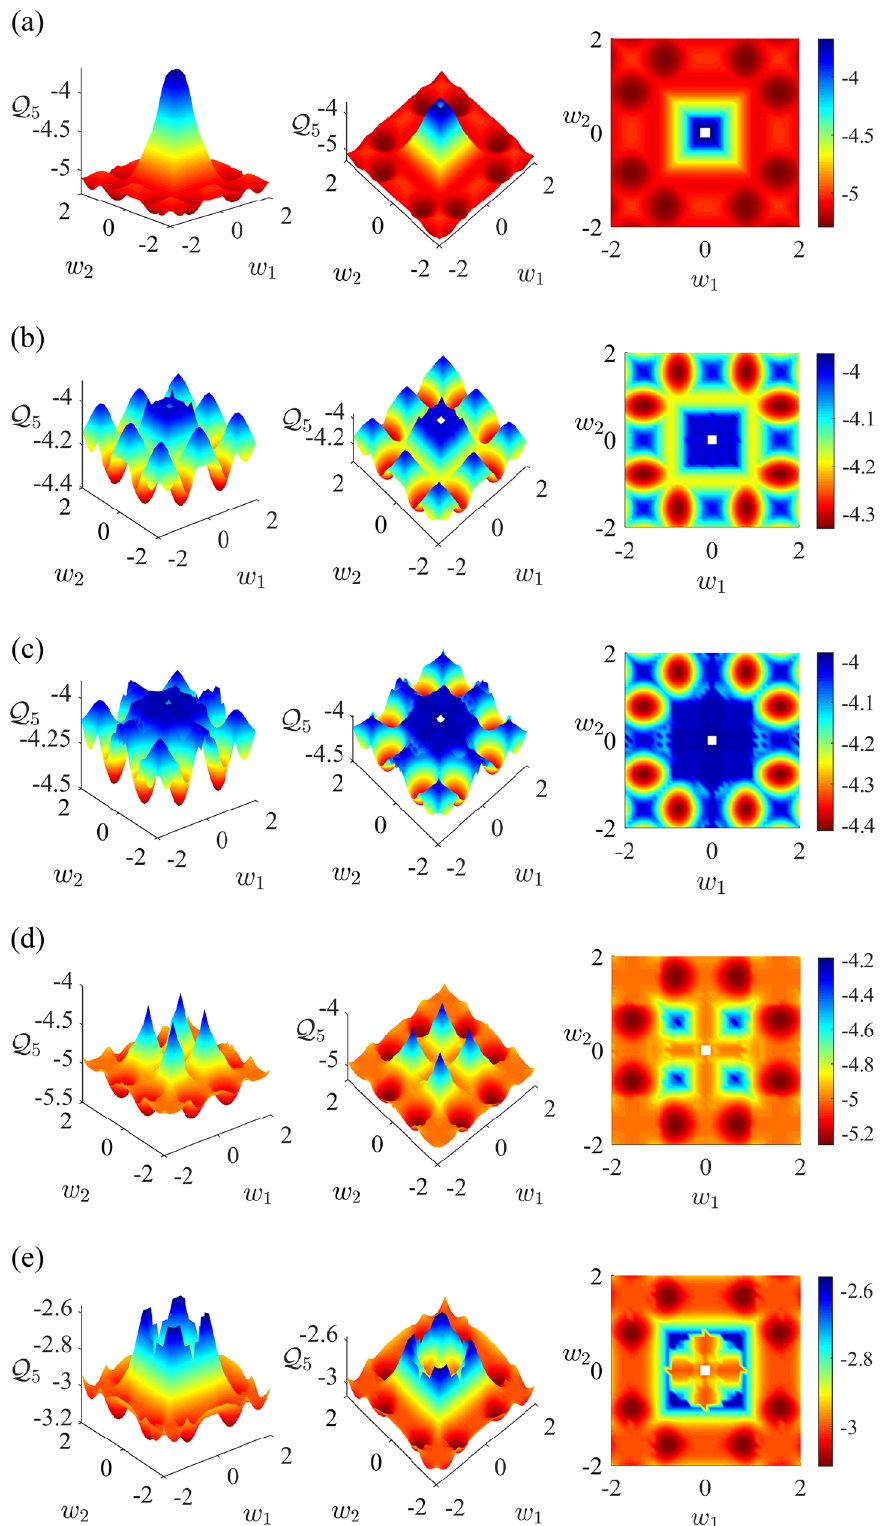
Fig. 7 Ground state energy surfaces for selected Hamiltonians with local dimension 5. Q 5 surfaces of fi ve models in Table 3 and Supplementary Table 2, where w 1 , w 2 both take discrete values on [ − 2, 2] at the interval 0.1. Three different viewing angles are shown for each model. The leftmost panel is a 3D overview, the middle panel is for better visualizing the internal structure, and the rightmost panel gives the top-down view. a No. 7 in Table 3, L ¼ (cid:3) 5 . b No. 8 in Table 3, L ¼ (cid:3) 4 . c No. 9 in Table 3, L ¼ (cid:3) 4 . d No. 10 in Table 3, L ¼ (cid:3) 5 . e No. 11 in Supplementary Table 2, L ¼ (cid:3) 3